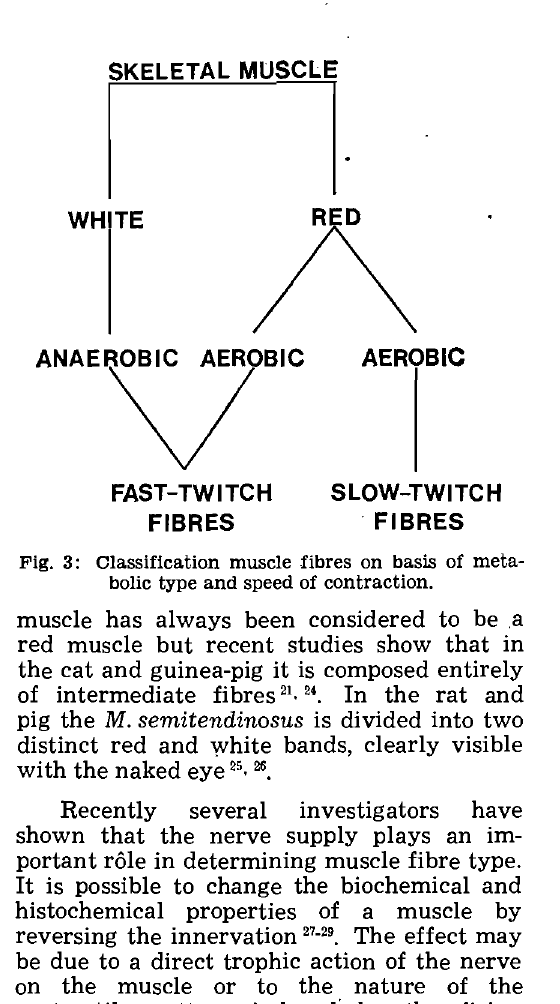
Fig. 3: Classification muscle fibres on basis of meta- bolic type and speed of